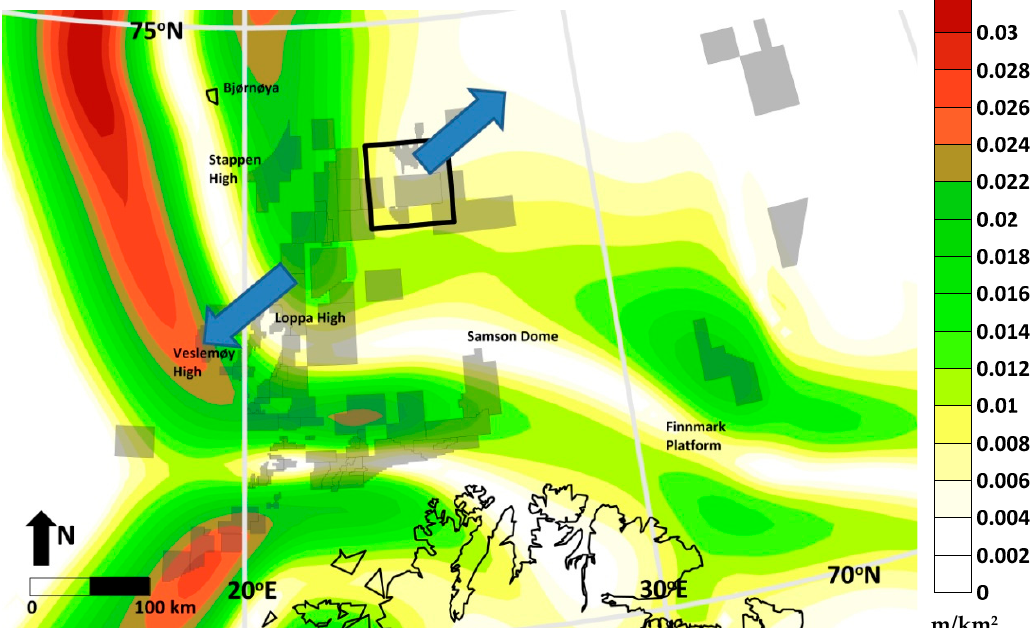
Figure 6. Second derivative, or curvature (m / km 2 ), of the isostatic response of the LGM ice sheet (Figure 1) in SW Barents Sea license area (white square of Figure 2). Yellow, orange, and green areas have high curvature and are likely to be influenced by stress effects during and after the glaciation. (cf. Figure 5). The black square marks the area included in the stress modeling, and the blue arrows show the orientation of maximum flexure-related extension after LGM deglaciation within that area.